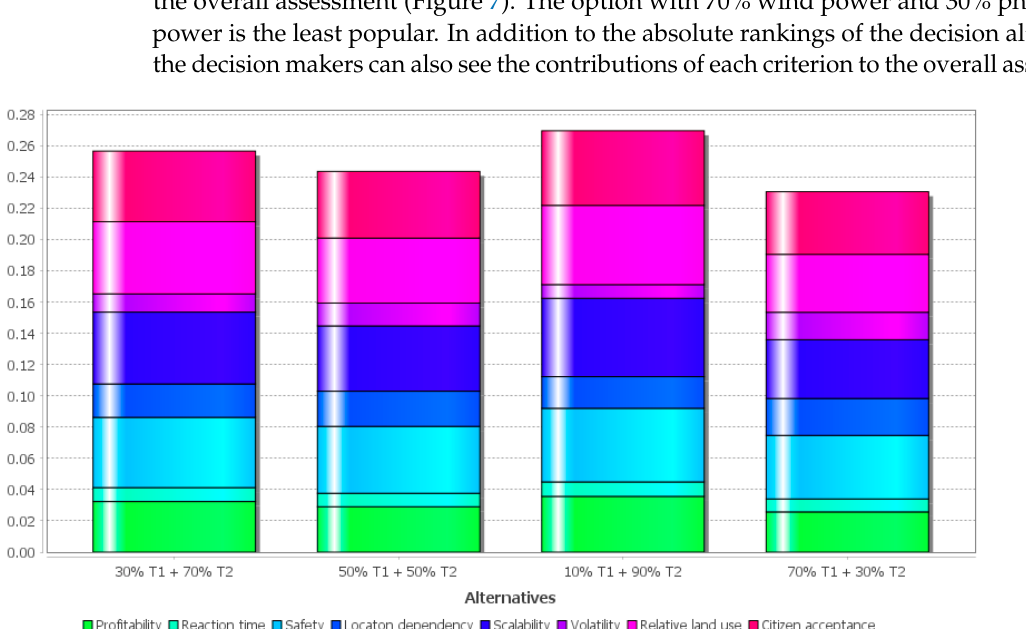
Figure 8. Effects of changing the weighting of the criterion “profitability” on the overall scores of the decision alternatives. The upper values of the x-axis are the absolute weights in the range 0 to 10. The lower values represent the relative normalized weights.